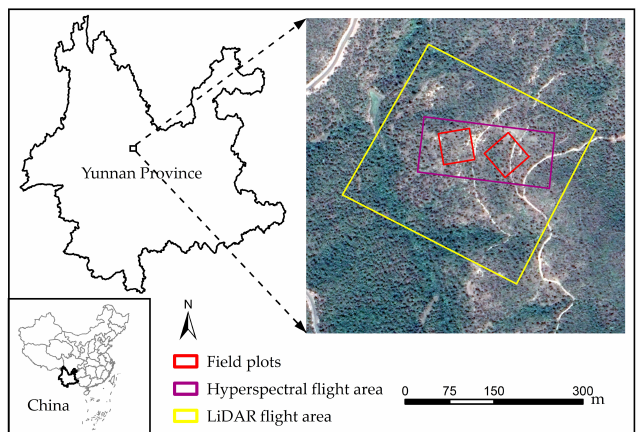
Figure 1. The location of the study sites and unmanned airborne vehicles (UAV) flight areas. The red rectangle represents two field plots locations, and the purple and yellow rectangles represent hyperspectral and lidar flight areas,